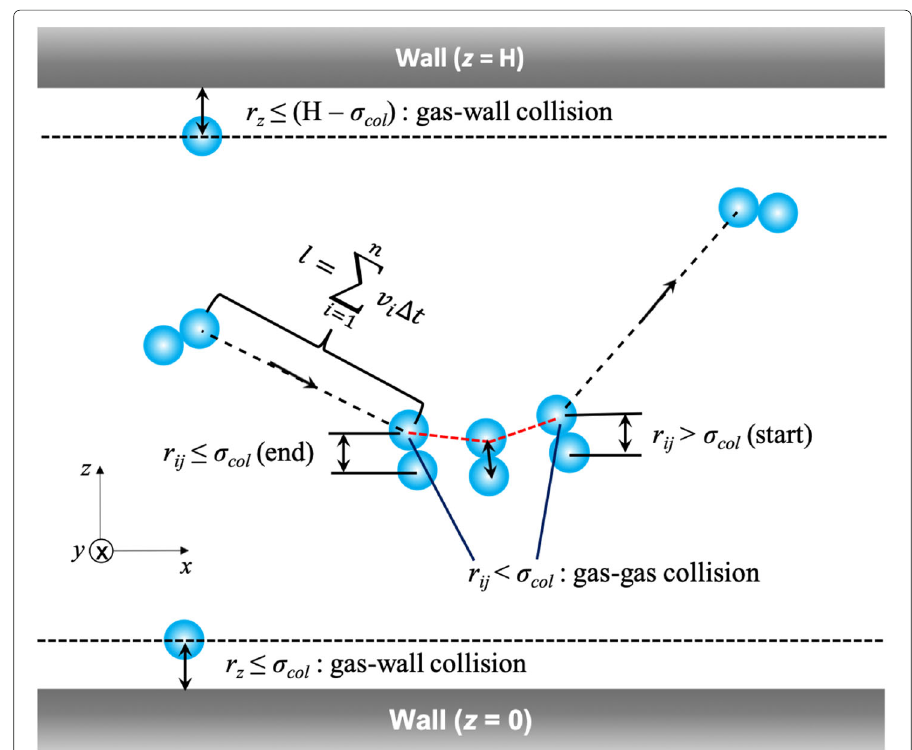
Fig. 1 Schematic of the calculation of individual free paths in molecular dynamics (MD) simulations: the parameters l and v are the individual free path and velocity of molecules, respectively; r ij is the distance between two molecules, σ col is the collision diameter which is used to determine the collision event; (cid:7) t is the time step in MD, and n is the number of time steps between two successive collisions of the i th molecule. It should be noted that x and y are orthogonal coordinate directions (i.e. the walls are oriented along the xy -plane) and the distance between the walls is along z